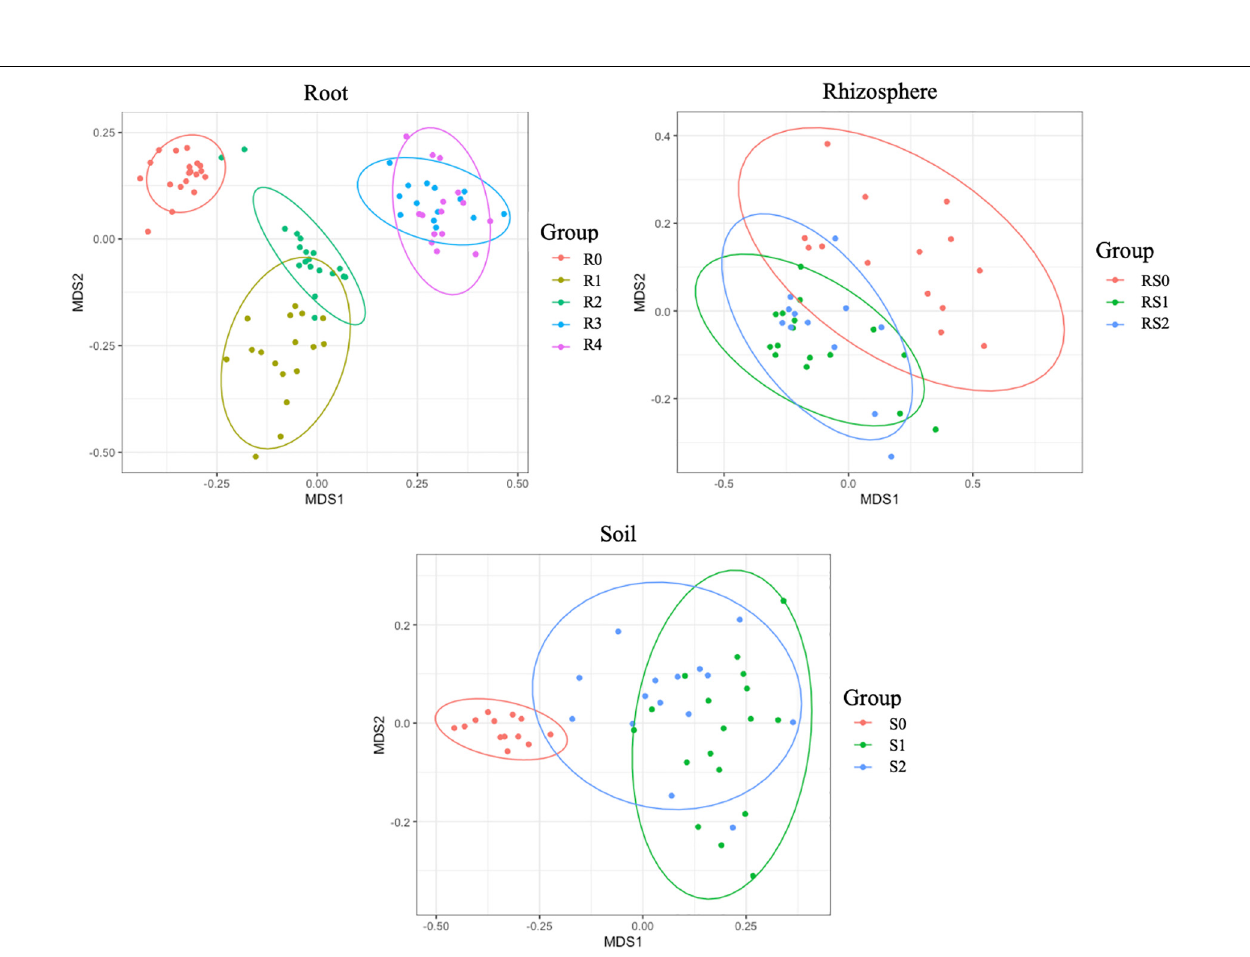
Frontiers in Microbiology |